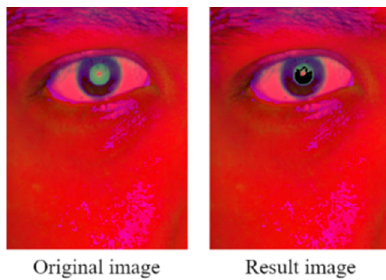
Figure 38. Pupil color distribution.